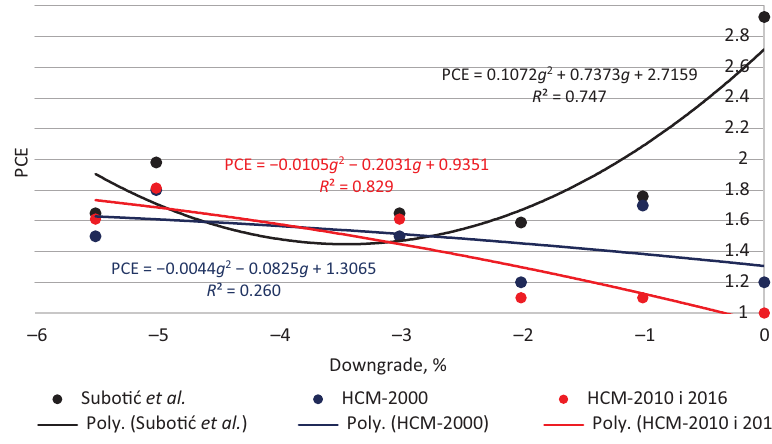
PCE = 0.1072 g 2 + 0.7373 g + 2.7159 R ² = 0.747